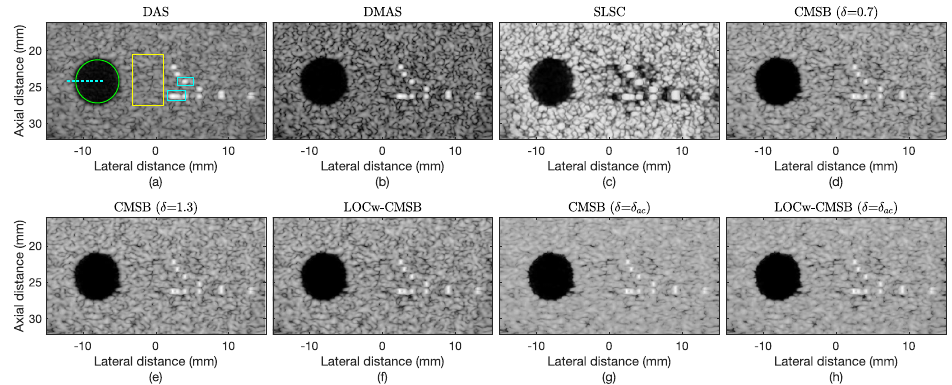
Figure 2. Simulated images reconstructed by ( a ) DAS, ( b ) DMAS, ( c ) SLSC, ( d ) CMSB ( δ = 0.7), ( e ) CMSB ( δ = 1.3), ( f ) LOCw-CMSB, ( g ) CMSB ( δ = δ ac ), and ( h ) LOCw-CMSB ( δ = δ ac ). Figure 3 plots the lateral variations through point targets indicated by cyan boxes and the cyst target indicted by the cyan dashed line. As can be seen, CMSB-based methods all obtain a narrowed mainlobe compared with DAS and DMAS as seen from Figure 3a. In addition, CMSB methods can distinguish the two closely spaced point targets as seen from Figure 3b. From Figure 3c, we can see that CMSB-based methods, as well as DMAS, obtain the lowest noise level in the cyst target. Additionally, LOCw-CMSB and LOCw-CMSB ( δ = δ ac ) obtain the best cyst edge resolution.